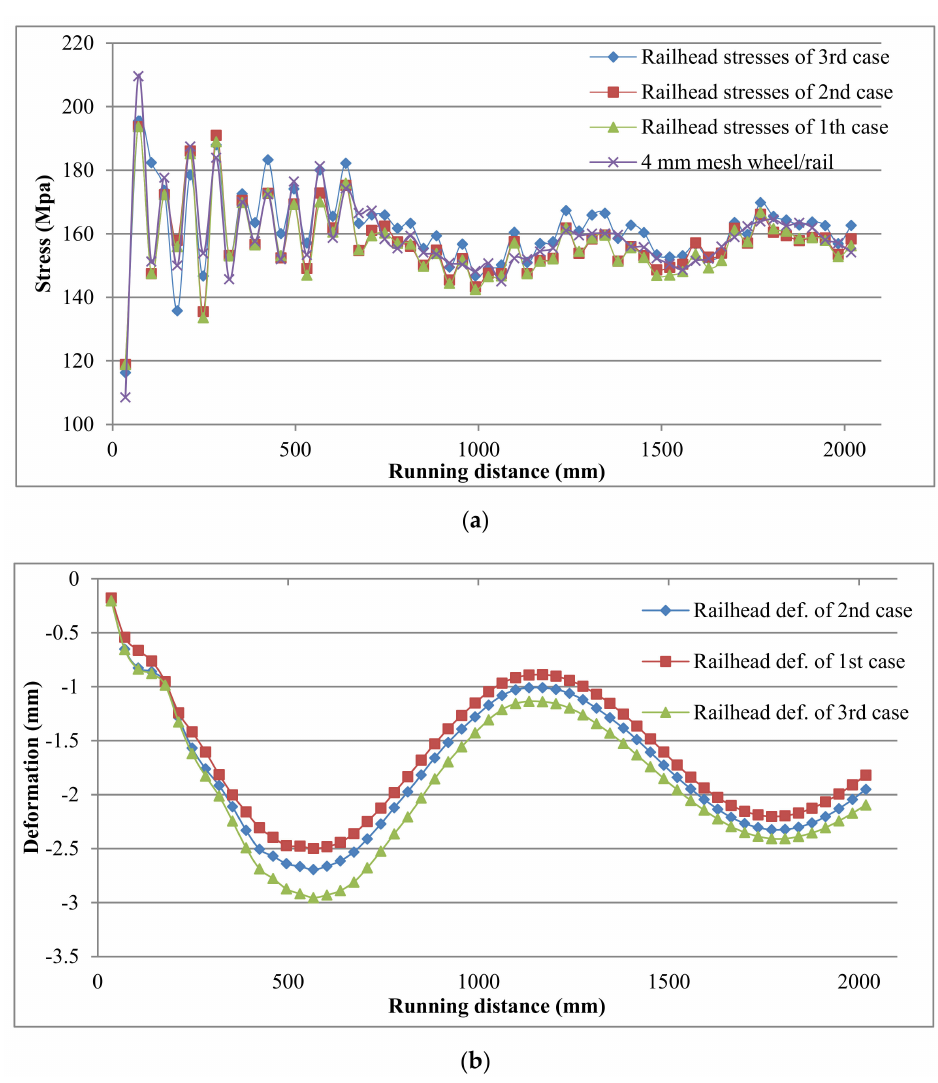
Figure 12. Railhead: ( a ) stresses; ( b )